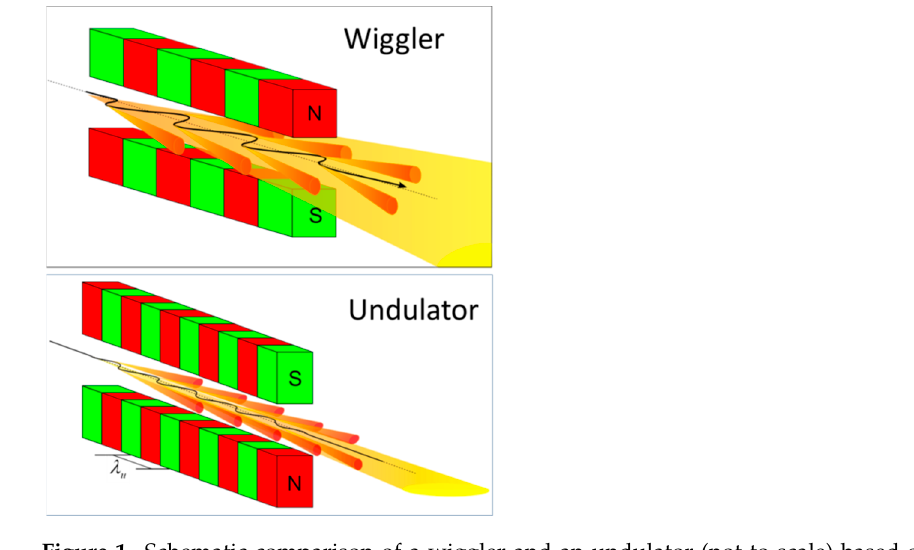
Figure 1. Schematic comparison of a wiggler and an undulator (not to scale) based on periodic magnet structure.